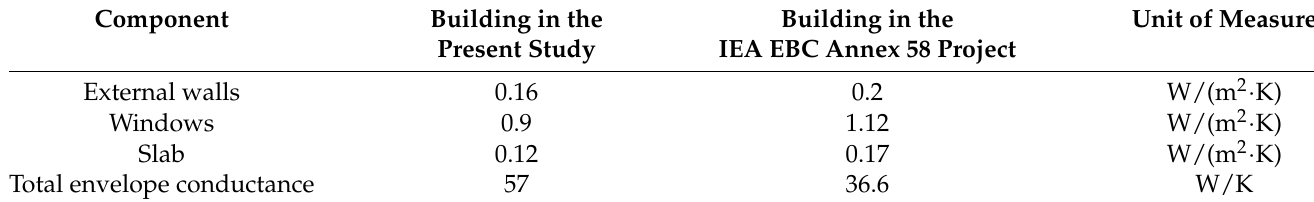
Table 2. Calculated heat transfer